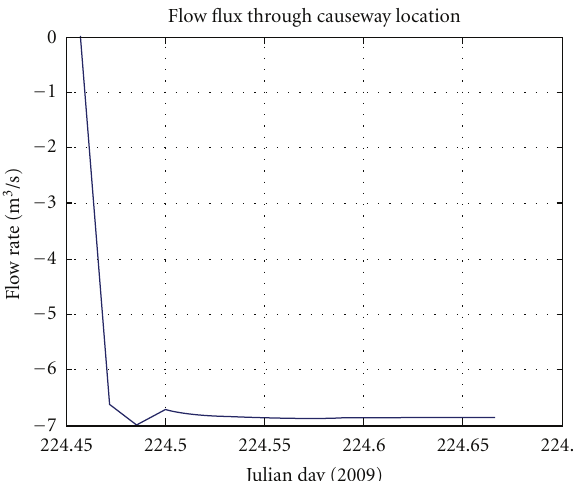
Figure 19: The exchange flow rate through a 15-meter-wide opening in the middle of the causeway induced by a constant east wind of 10m/s.